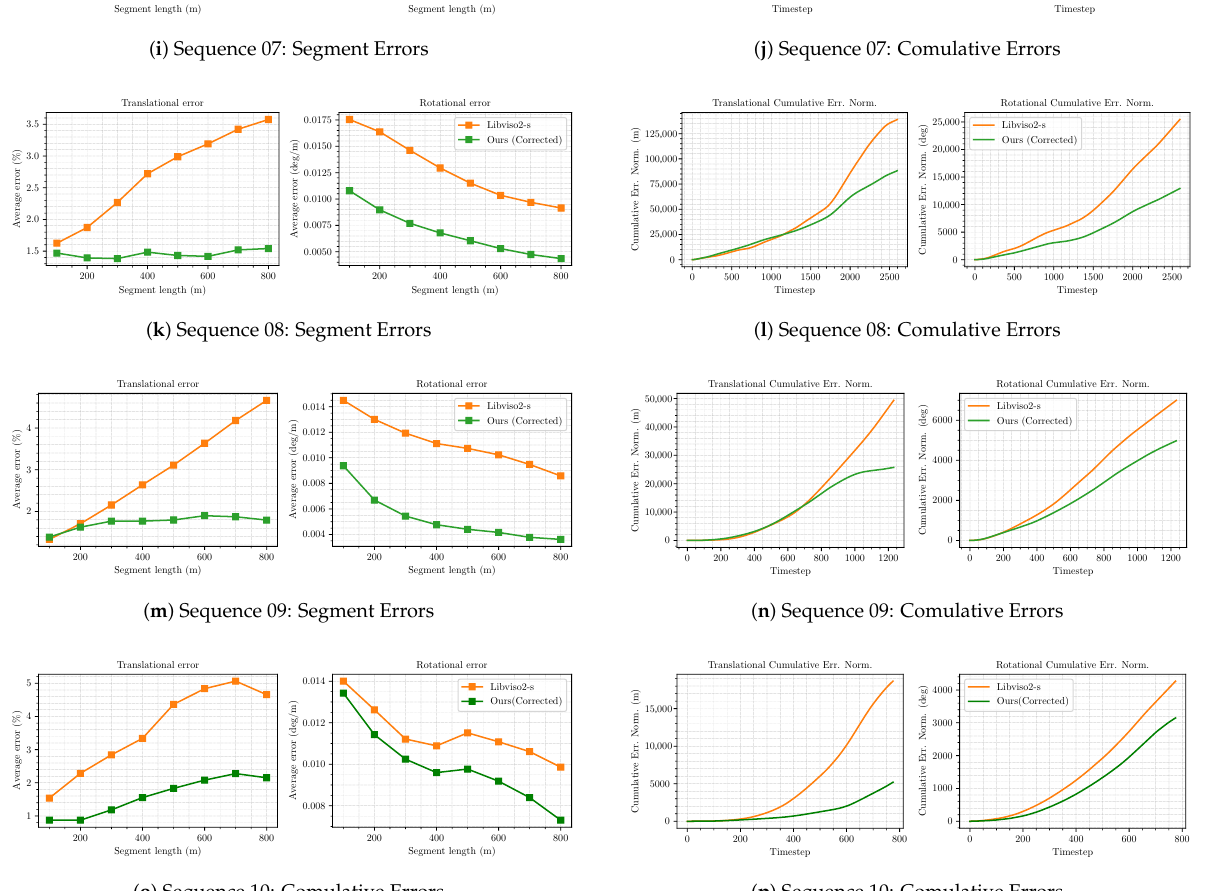
Figure 6. Mean segment errors and c-ATE for libviso 2- s with and without pose correction net on KITTI sequences 00, 02,